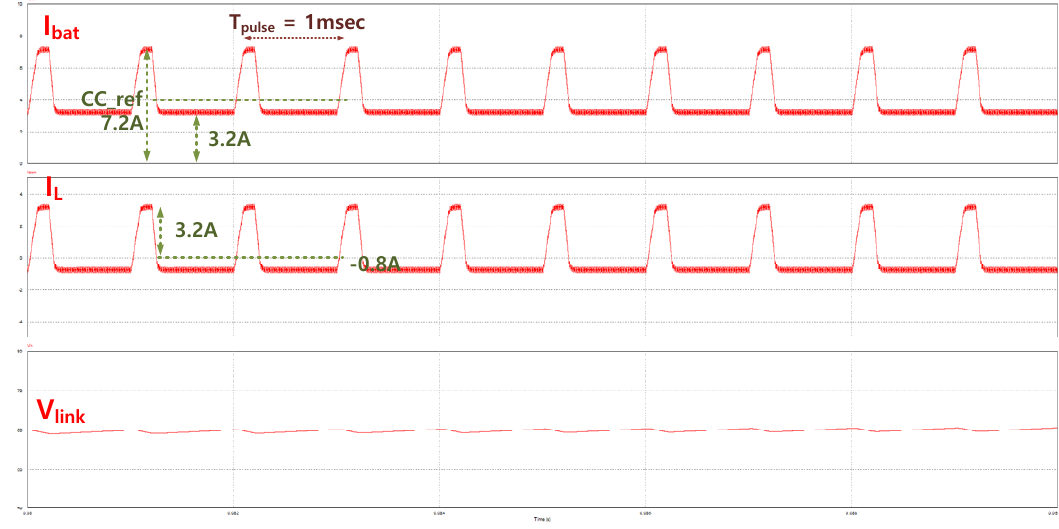
Figure 11. Results of the simulation at a 20% pulse duty ratio and 1000 Hz pulse frequency. Based on the simulation, the battery was tested for pulse charging. To charge the battery with a CC, a diagram of the test equipment was constructed as shown in Figure 12a. A prototype of an add-on pulse charger is shown in Figure 12b. Figure 12c shows the configured experimental set. DC power supplies and electronic loads were used to construct a constant current charging system. The battery consisted of 10 series and two parallel structures. Oscilloscopes and data loggers were used to collect the characteristic battery data by pulse